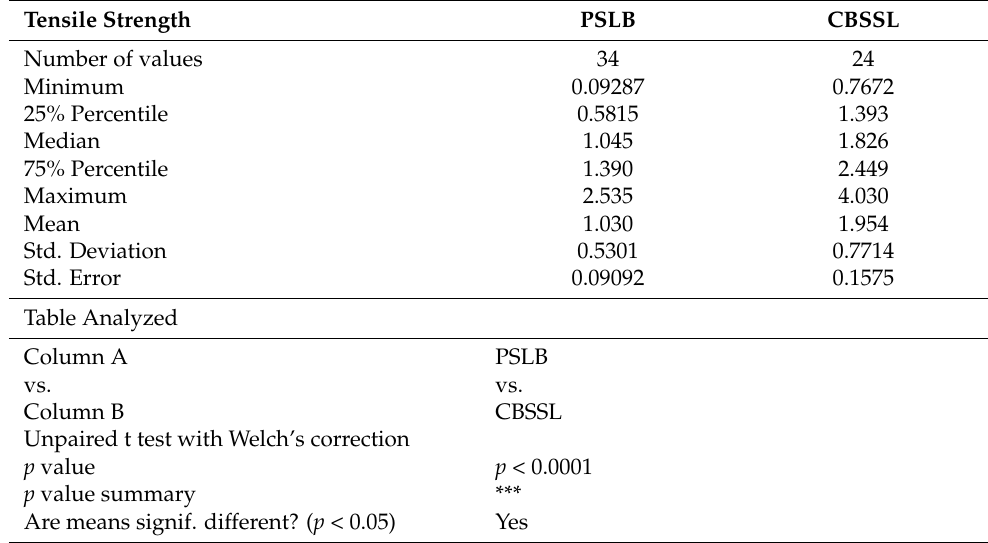
Table A11. Tensile strength: passive self-ligating vs. conventional brackets with stainless steel ligatures.